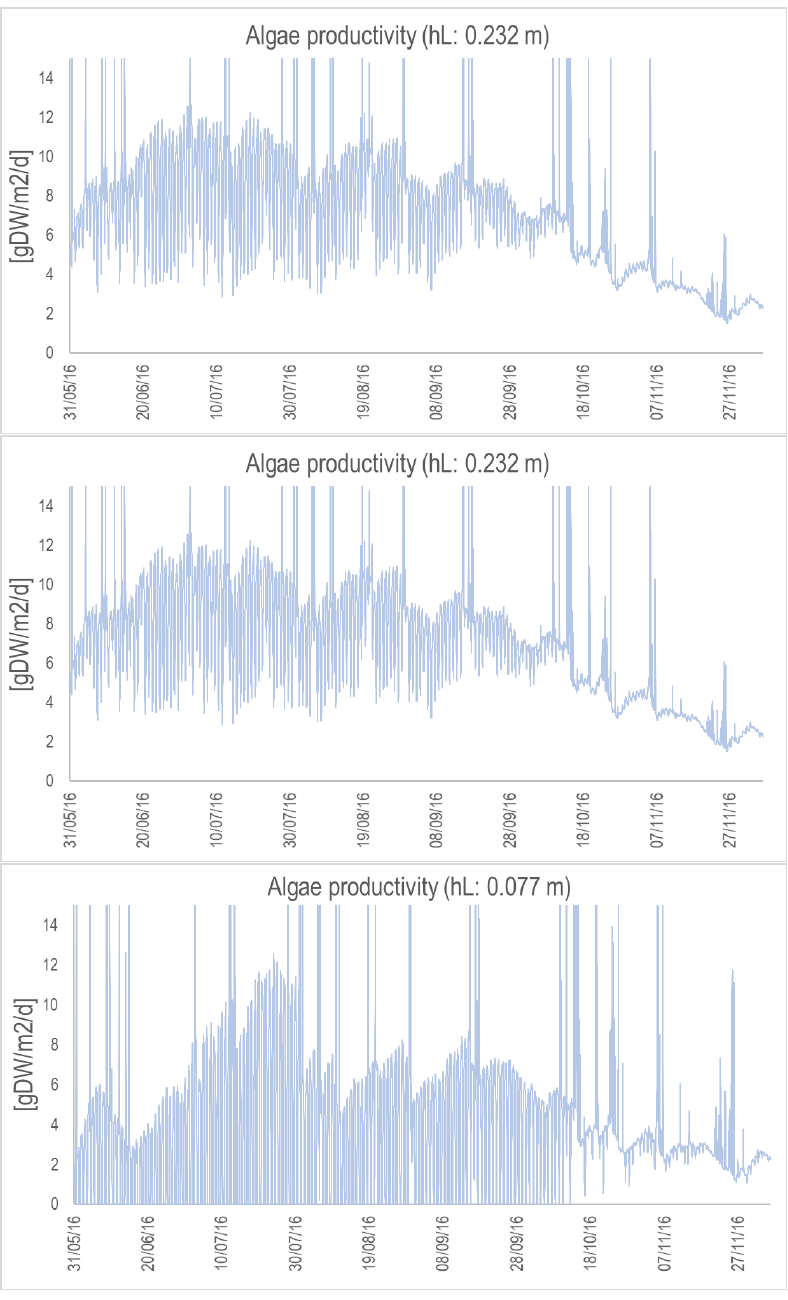
Figure A5. Algal productivity (in gDW/m 2 /d) for the concrete raceway with the nominal depth ( top ), depth divided by 2 ( middle ), and depth divided by 3 ( bottom ). Simulations are from May to November